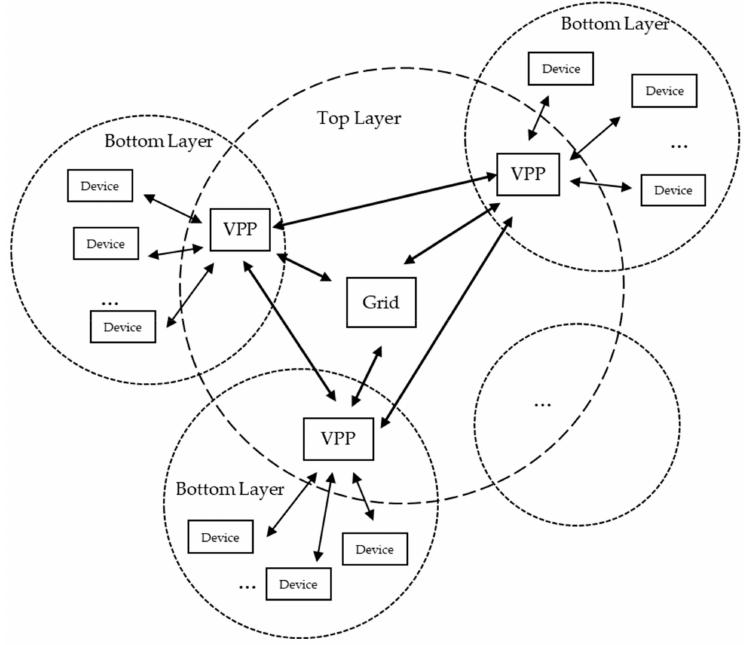
Figure 1. Schematic diagram of the peer-to-peer (P2P) energy trading mechanism involving two interactive